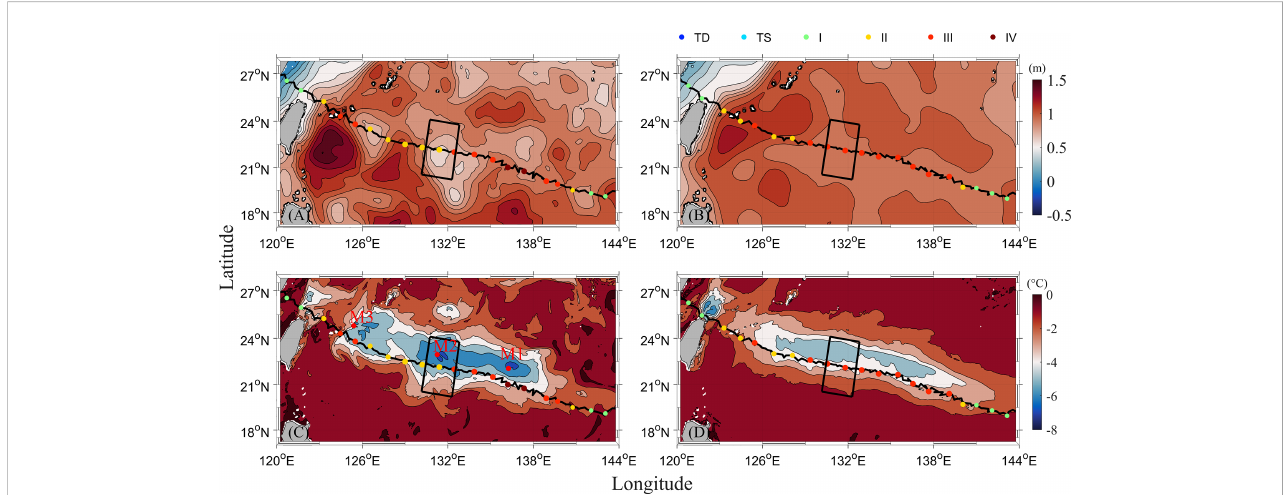
FIGURE 6 Sea level on July 8 (A, B) and corresponding maximum sea surface cooling distribution (C, D) in (A, C) EXP HYCOM and (B, D) EXP CLIMAT . The red dots (M1, M2 and M3) in (C) are the cooling centers within the corresponding preexisting CEs (refer to those in Figure 5). The black box shows the domain for CE2. The black curve is the track of Typhoon Soulik. The other symbols are the same as those in Figure 3.